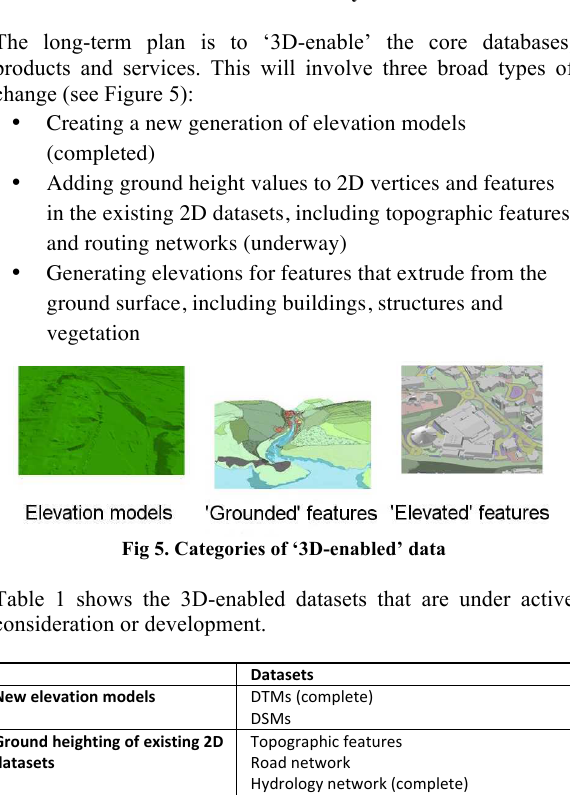
Fig 4. Example of 3D building generalization, from the BT-5M to the BT-25M